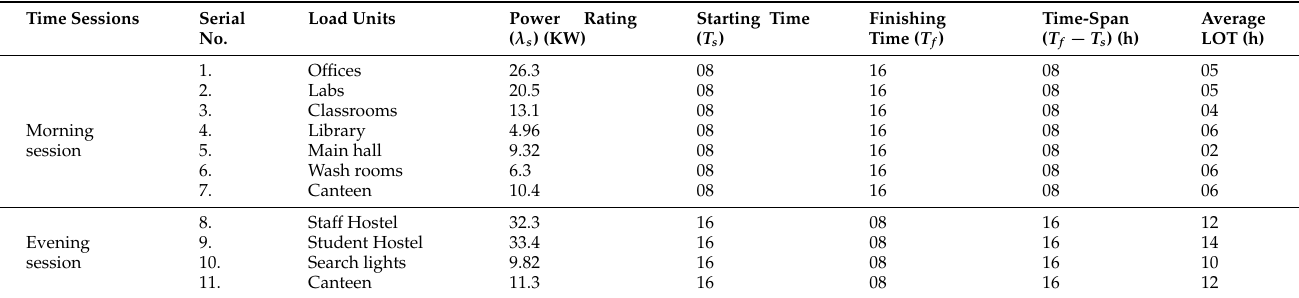
Table 1. Campus load units and their